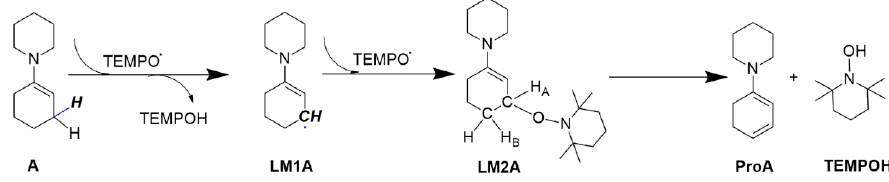
Figure 1. Calculated elementary steps for oxidation of enamine molecule A by TEMPO.